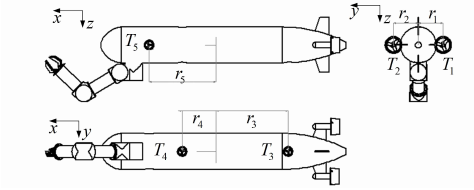
Figure 5. Thruster distribution of the AUV. Table 3. D-H parameters of the